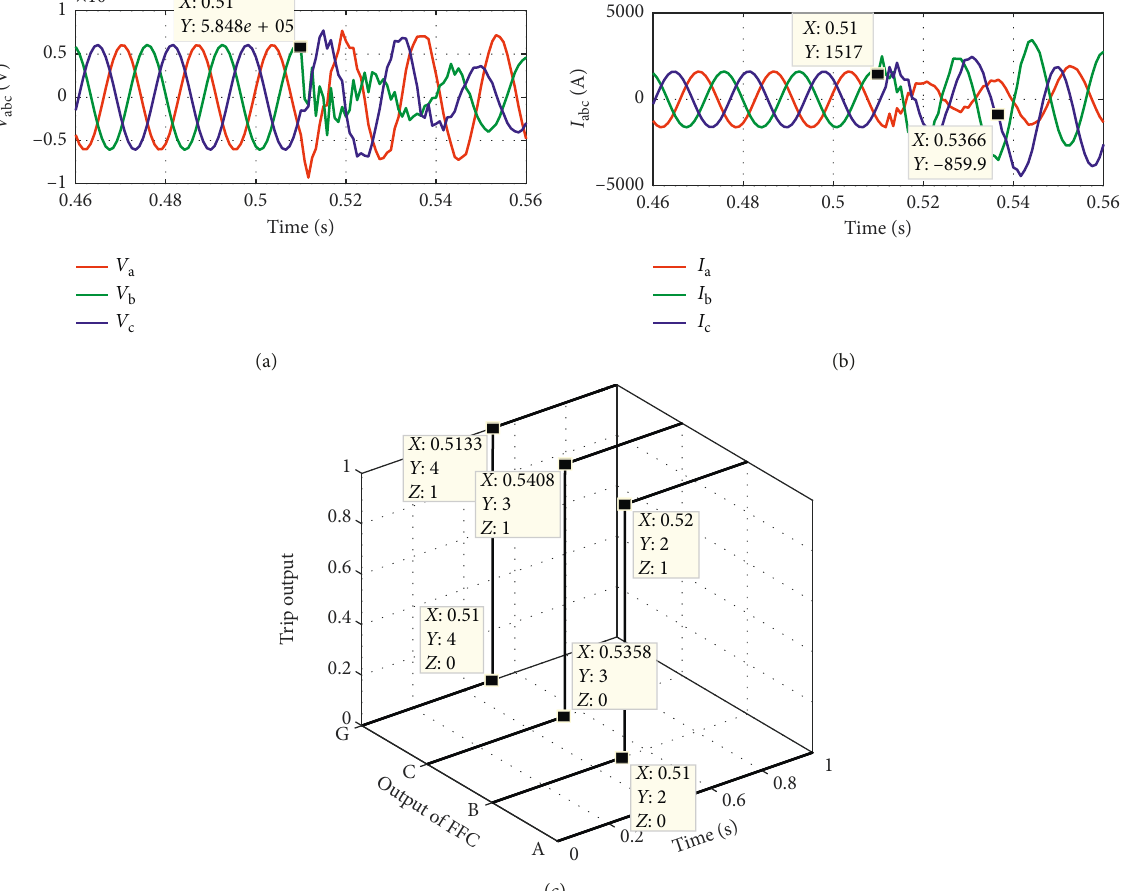
Figure 8: Performance during evolving fault case BG to BCG fault at 90km, FR1 � 15 Ω , and FR2 � 50 Ω : (a) 3-phase voltage waveform; (b) 3-phase current waveform; (c) output of Table 9: Simulation results for different compensation levels (BCG fault, FR � 10 Ω , and FL � 165 km). Simulated system data